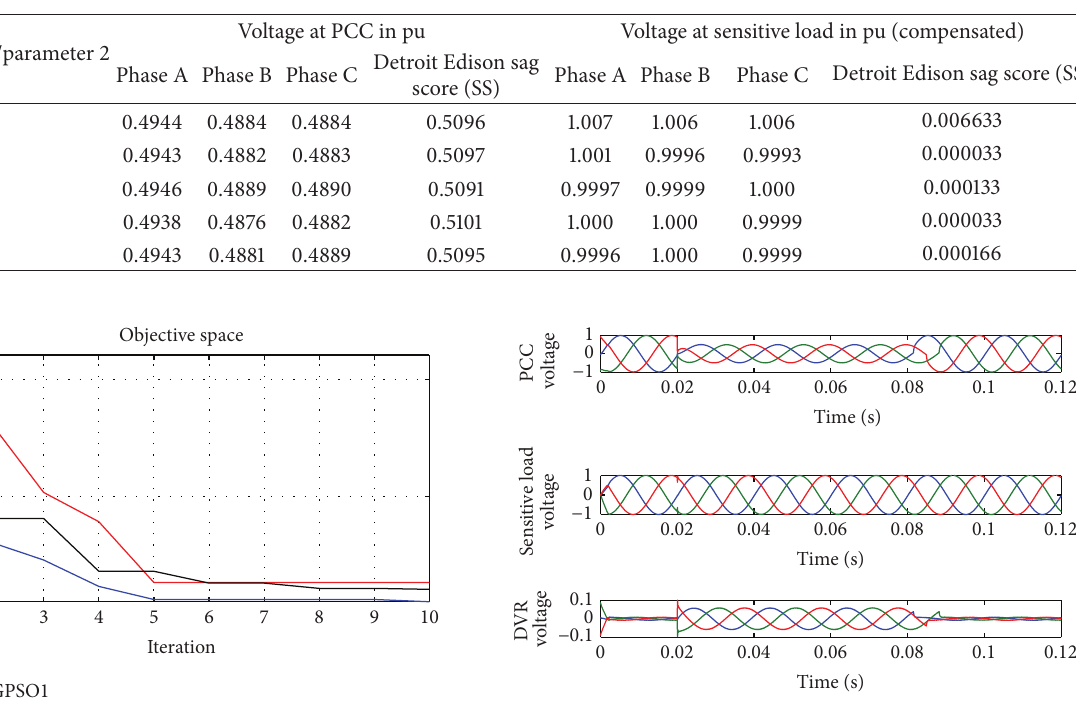
Table 2: Voltage sag compensation of three-phase balanced fault.